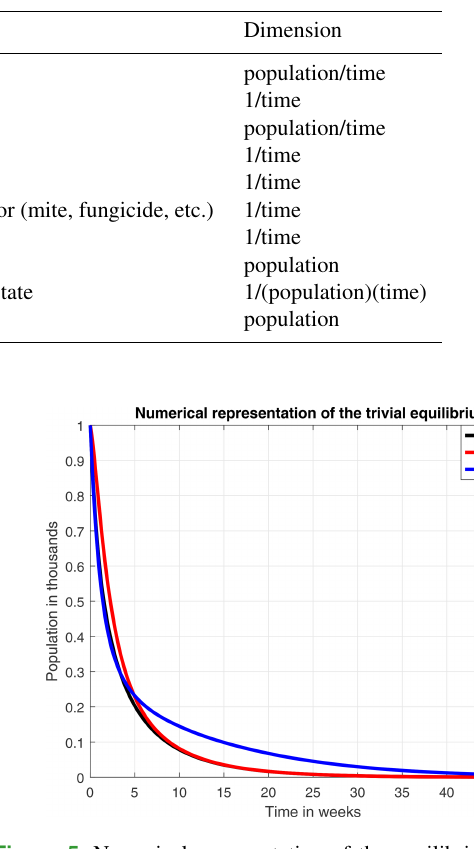
Figure 5. Numerical representation of the equilibrium E 0 . Here, λ ∗ = 0 . 7564 and ν =